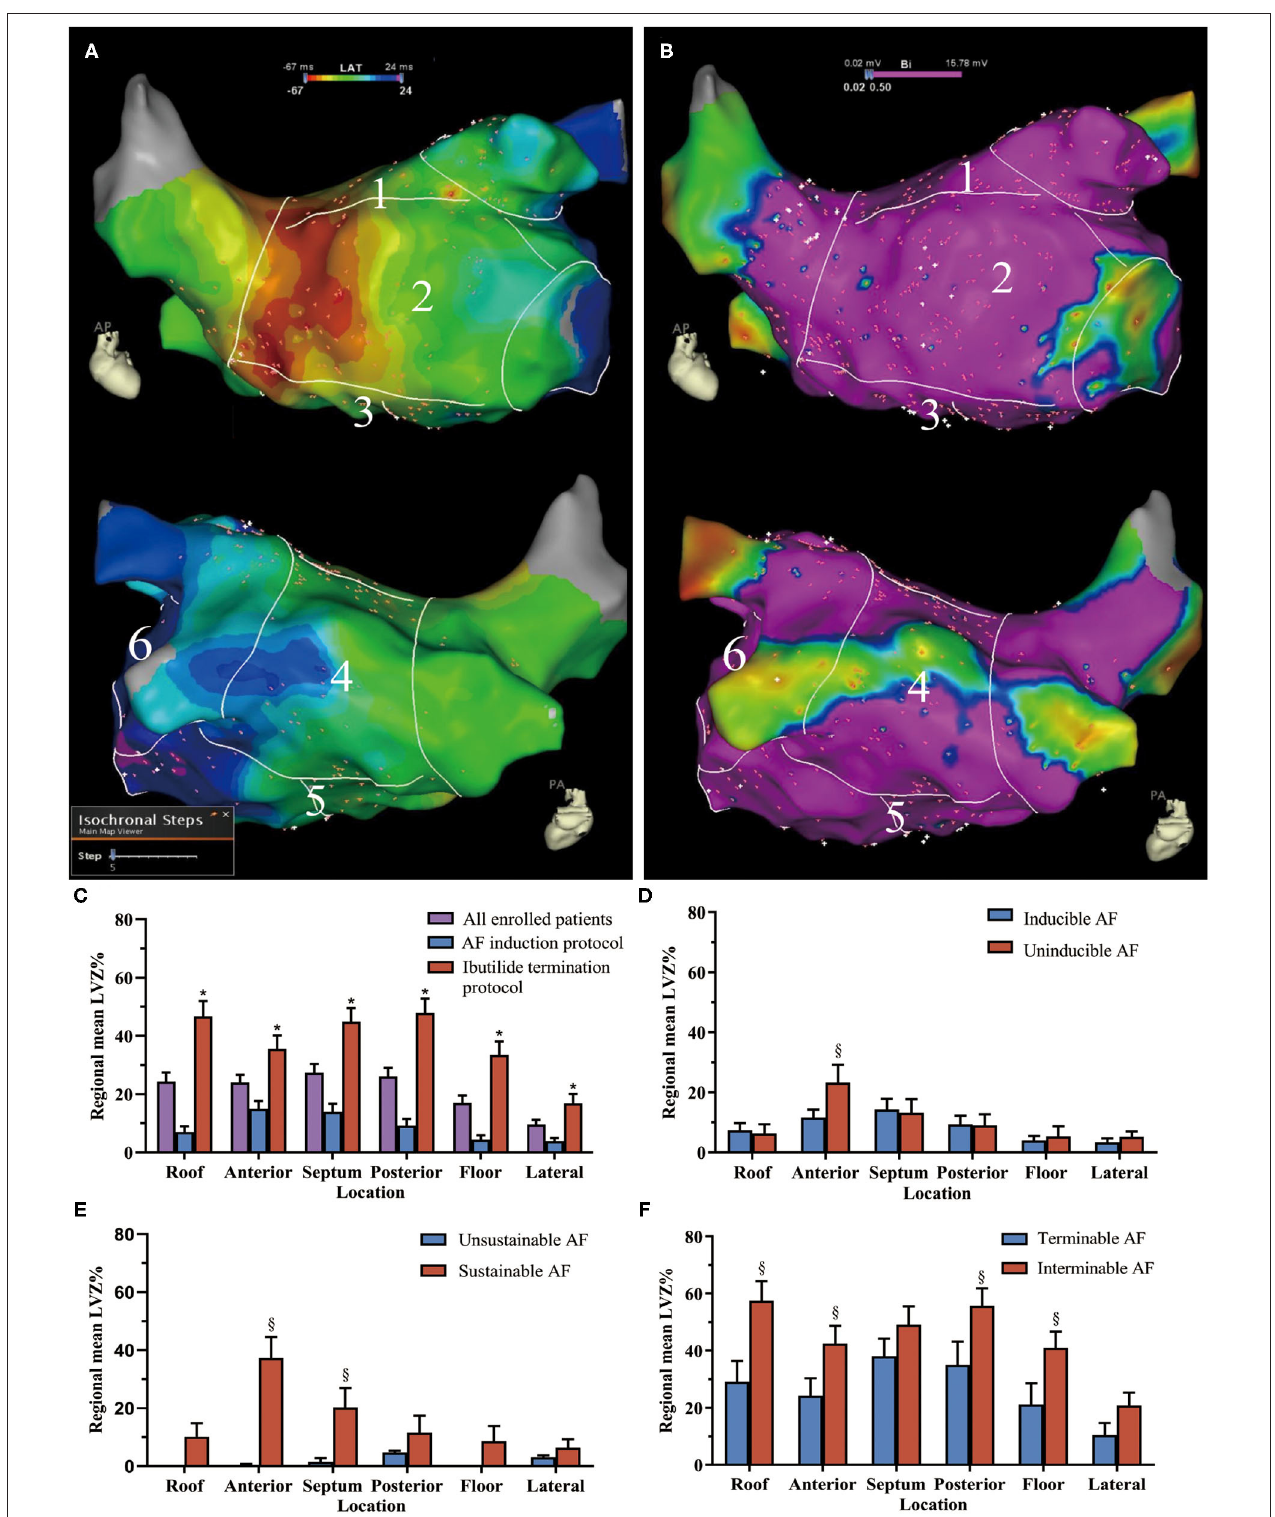
FIGURE 2 | The low-voltage zone (LVZ) distribution in different atrial segments. Example for the six segments of (A) the left atrium (LA) in the activation map and (B) bipolar voltage map (1 = roof, 2 = anterior wall, 3 = septum, 4 = posterior wall, 5 = floor, and 6 = lateral wall). In the voltage map, areas in purple indicate healthy myocardia with sinus voltage ≥ 0.5mV, areas with color range from red to blue indicate LVZ with voltage < 0.5mV. (C) The LVZ distribution in all enrolled patients and